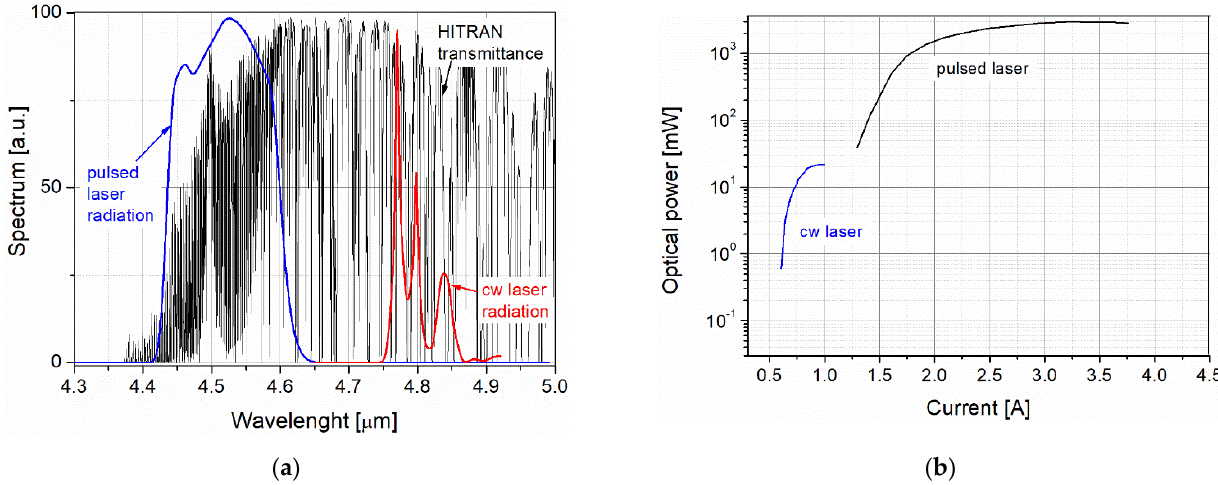
Figure 5. ( a ) Spectrum and ( b ) optical power-current (L-I) characteristics of both quantum cascade (QC) lasers. For laser radiation, the same current driver was applied. The light beam was formed using an off-axis parabolic mirror with a three-inch diameter and a two-inch focal length. This setup collimated ~75% of the laser output power. The collimated beam was collected on the mercury-cadmium-telluride (MCT) photodetector with a four-inch parabolic mirror. The photodetector was mounted with an amplifier in a detection module fabricated by the VIGO System company. To determine the data link range, it was necessary to define several parameters of the FSO components (Table